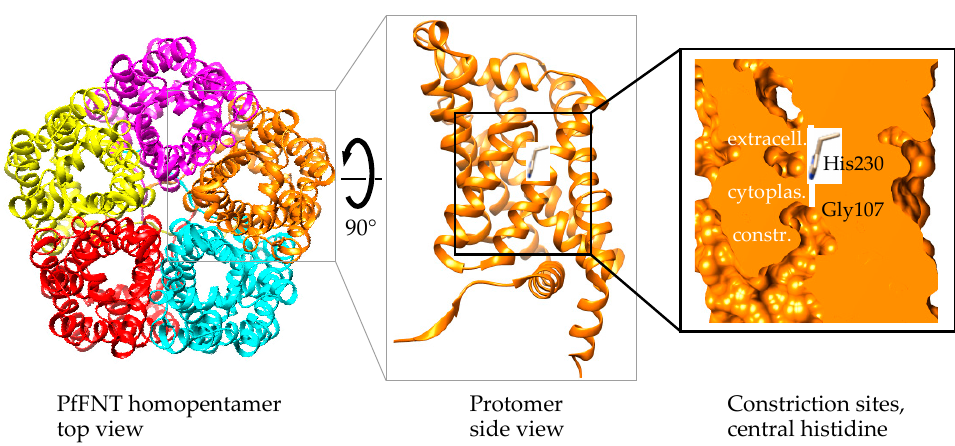
Figure 2. PfFNT protein structure. Shown are the homopentamer (PDB# 7e26) as seen from the extracellular side (left), a protomer in side view, and a space-fill display of the internal transport pathway with two constriction sites that sandwich a highly conserved, central histidine residue.